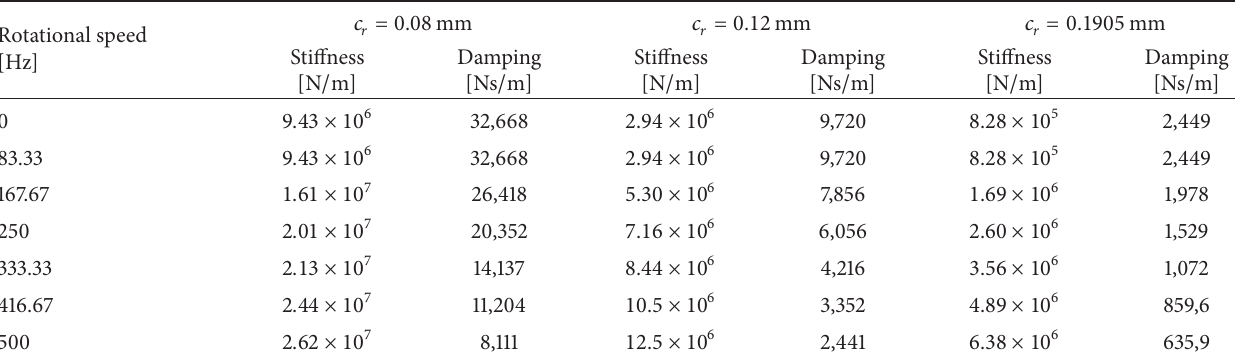
Table 2: Stiffness and damping dynamics coefficients of the rear bearing as a function of the rotational speed for three different radial clearances of the squeeze film damper.